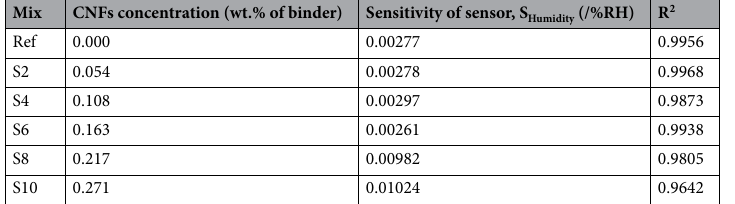
Table 4. Calculated sensitivity and R 2 for the produced humidity sensors cured at 97%